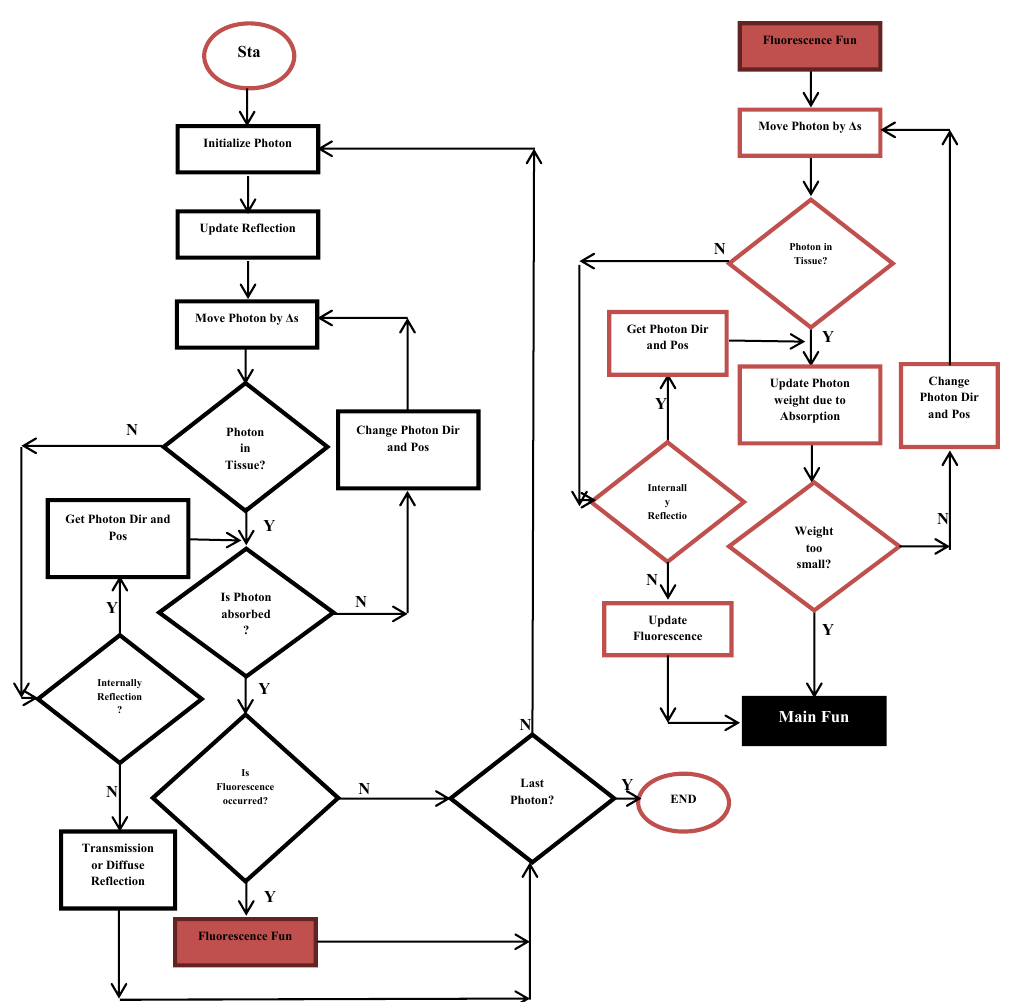
Fig. 2. MC Method Algorithm Flow Chart; Dir: direction, Pos: position; “N” and “Y” stand for No and Yes